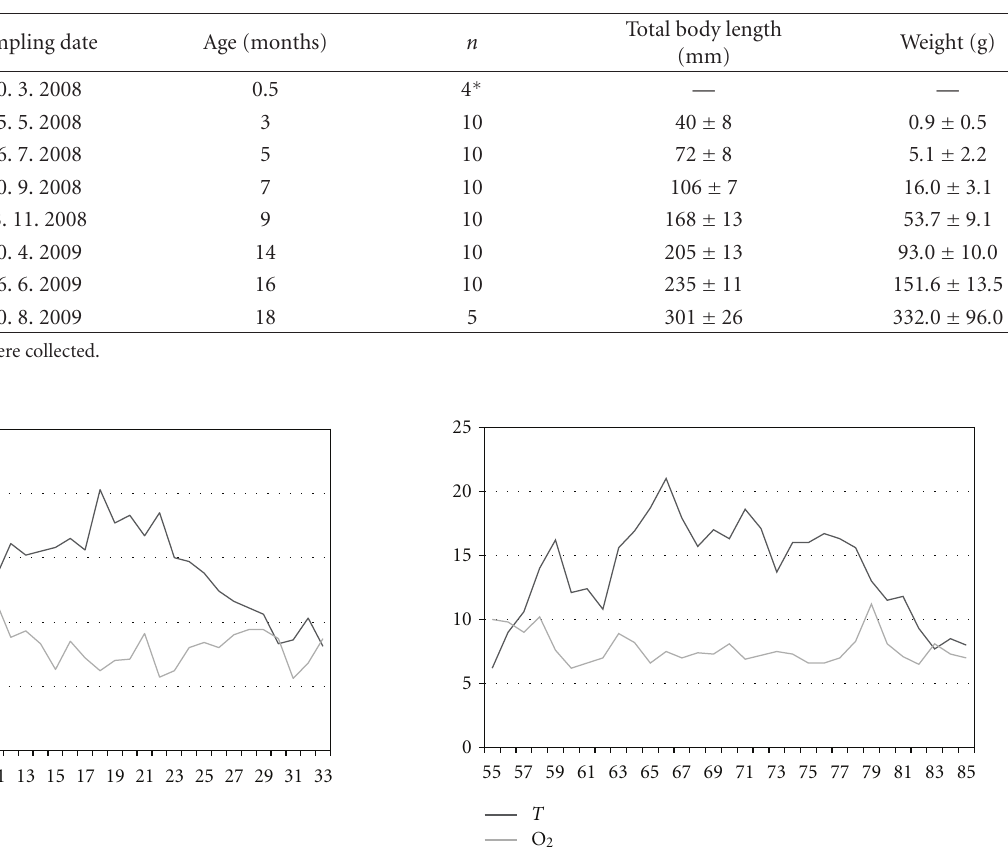
Table 1: Characteristics of fish groups analyzed.